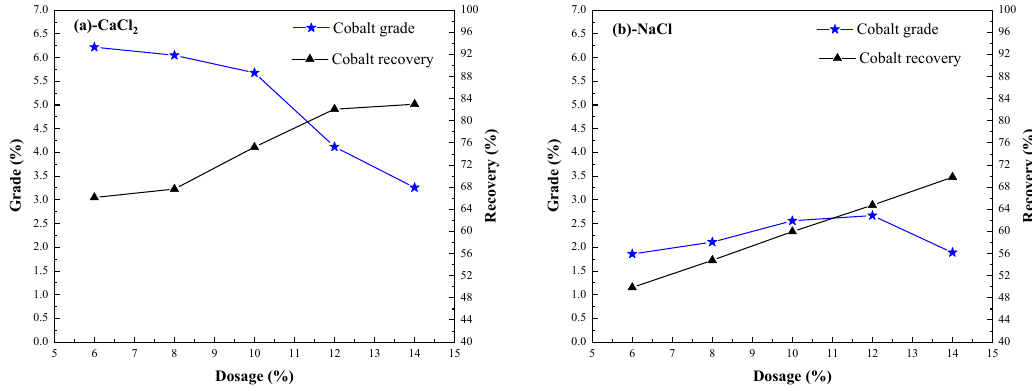
ff ect of chlorinating agent dosage on cobalt Figure 7. Effect of c hlorinating a gent d osage on cobalt extraction. Figure 7. E